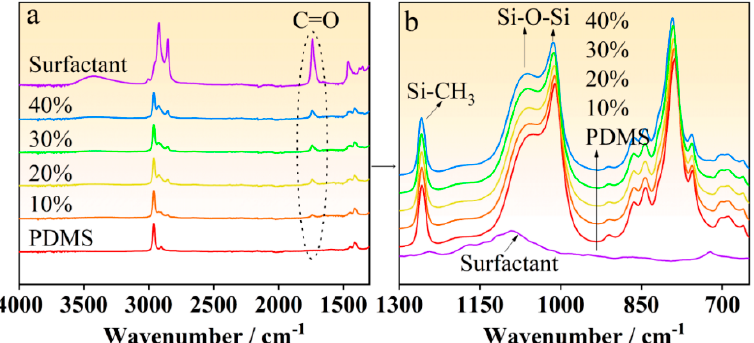
Figure 3. ( a , b ) Attenuated total reflection infrared spectroscopy (ATR-IR) spectra of 10%–40% samples in contrast to pristine PDMS and hybrid surfactant.